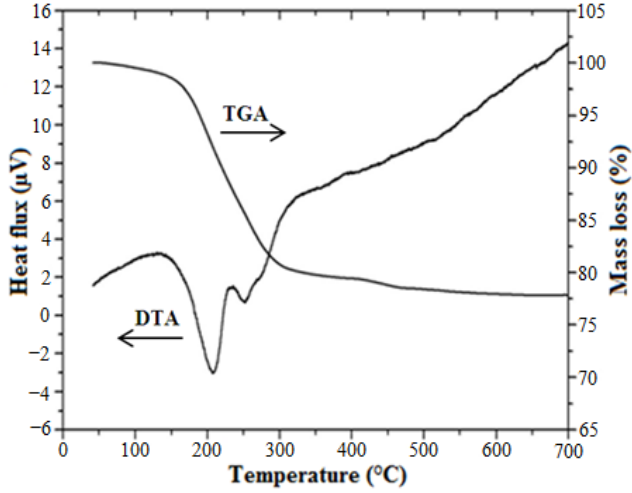
Figure 3. TGA/DTA curve of LDH material.